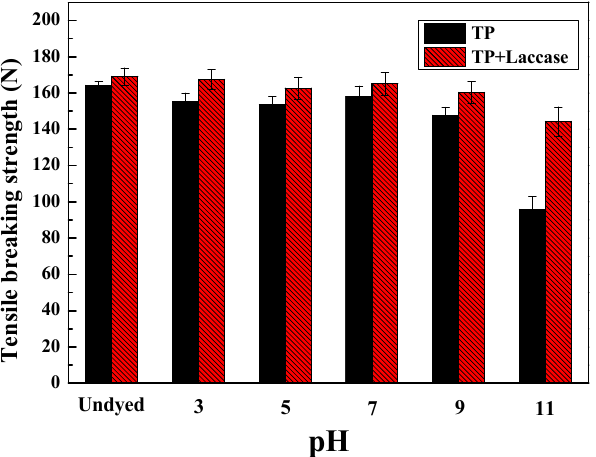
Figure 9. Effect of pH value on breaking strength of dyed wool fabrics.